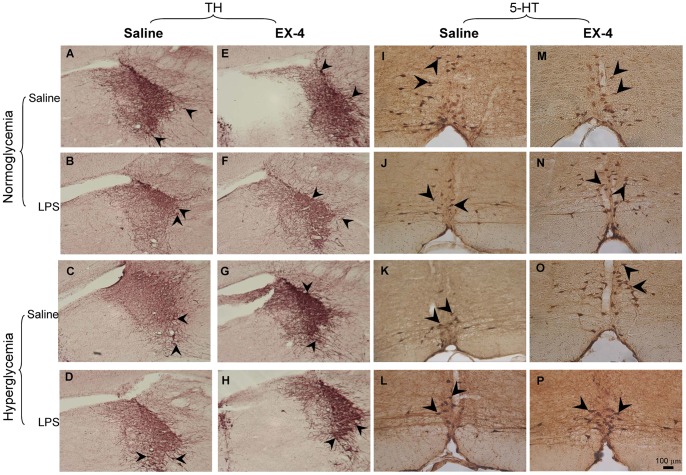
Immunohistochemical analysis of noradrenergic and serotonergic neurons.(A–H) Representative immunostainings of noradrenergic neurons in the locus coeruleus (LC) region. (I–P) Representative immunostainings of serotonergic neurons in the Raphe nucleus. Scale bar = 100 µm. Arrowheads indicate positive staining signals (n = 3–5 per group).